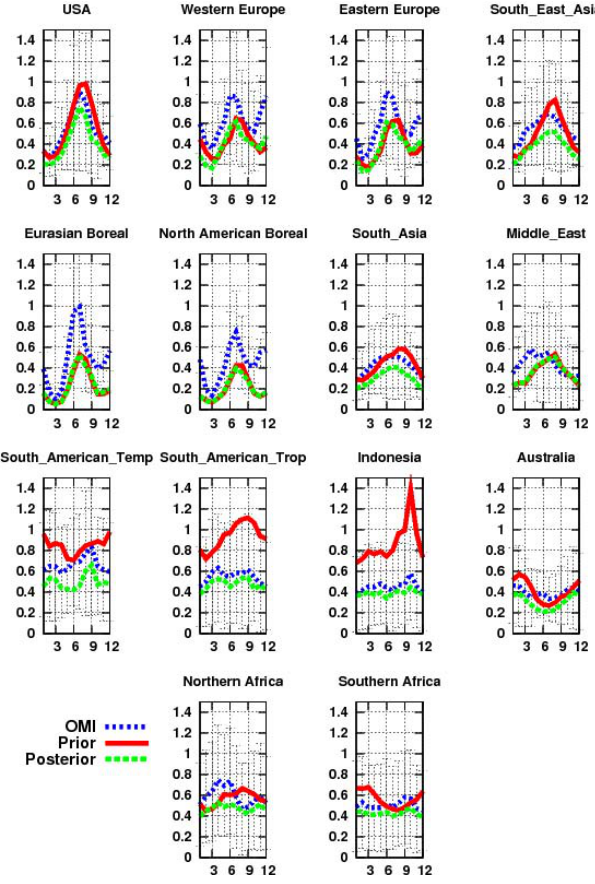
Fig. 4. Times series of monthly averaged formaldehyde total columns retrieved by OMI (in blue) and simulated by the model LMDz-SACS using the prior (in red) and the posterior fluxes (in green) for year 2006, from January to December. Error bars repre- sent the OMI retrieval errors. Units are 10e 16 moleccm − 2